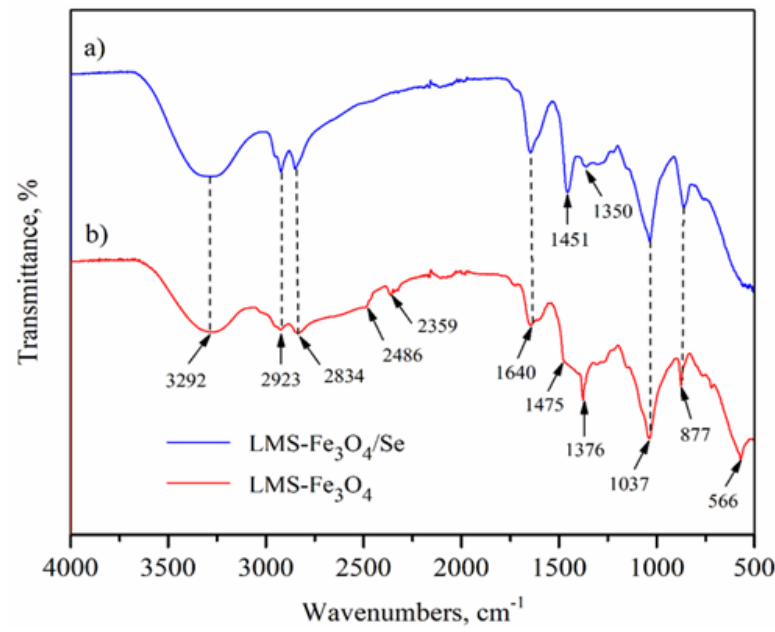
Figure 6. The FTIR spectrum of Se loaded A-LMS Fe 3 O 4 adsorbent, ( a ) after adsorption; ( b ) before adsorption